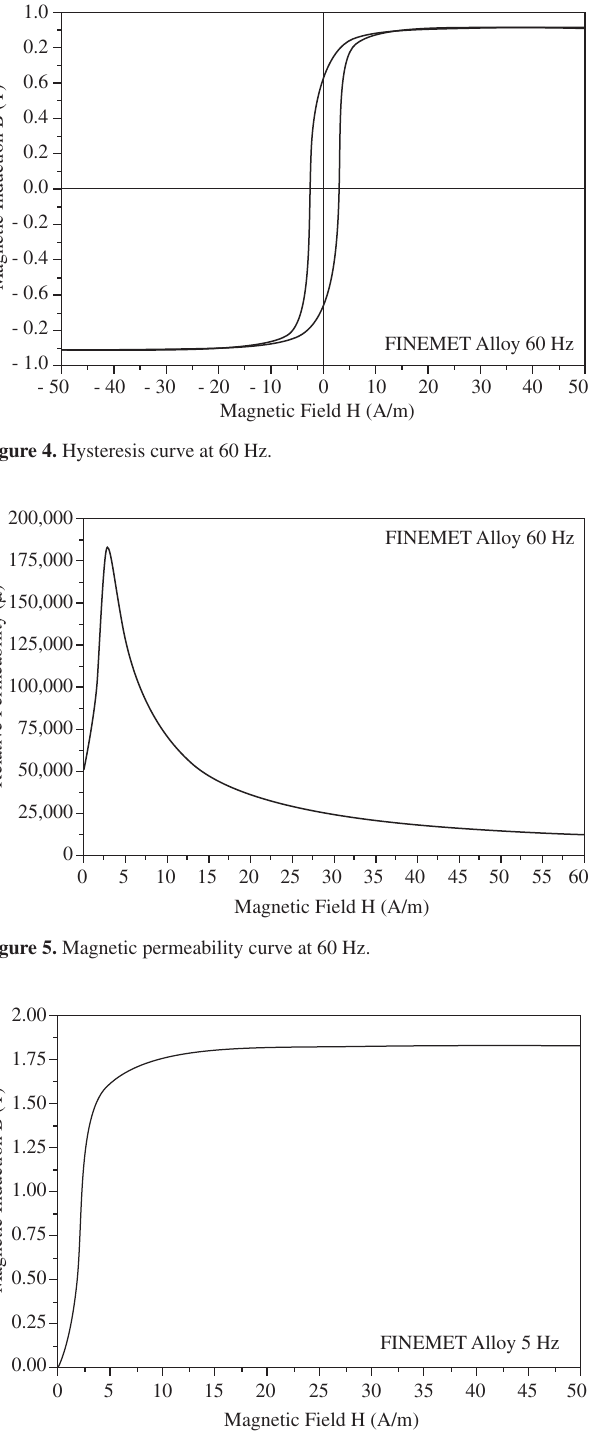
Figure 6. Initial magnetization curve at 5 Hz.